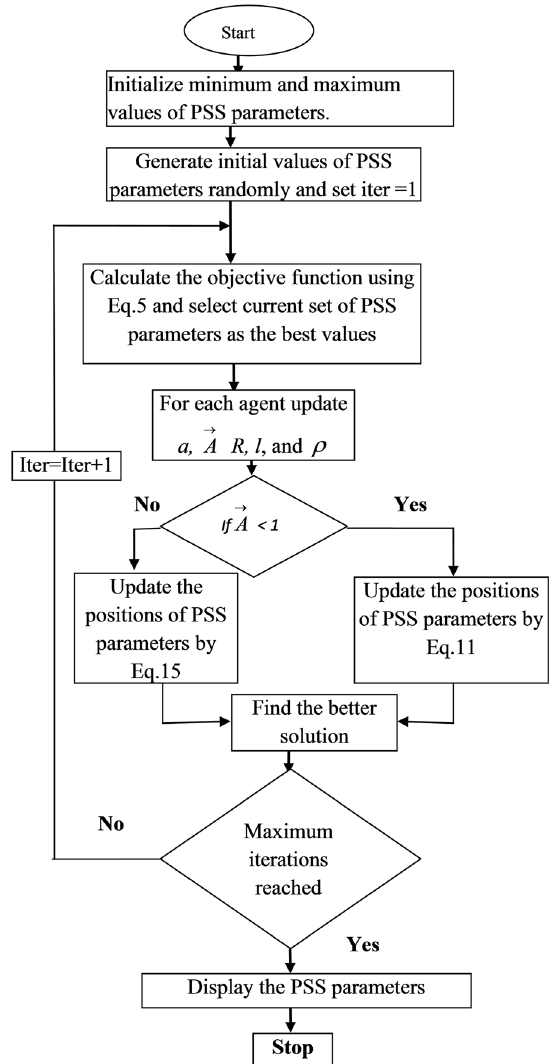
Fig. 5 Flowchart for WOA to design the PSS parameters